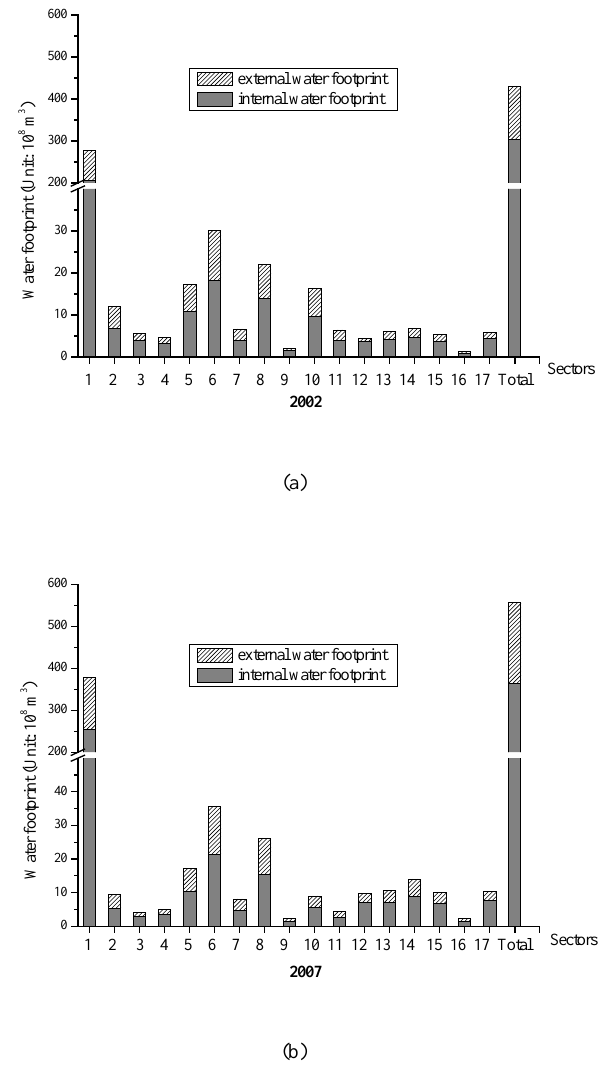
Fig. 2. WFs in the HRB in 2002 (a) and 2007 (b) . Figure 2. WFs in the HRB in 2002 (a) and 2007 (b)